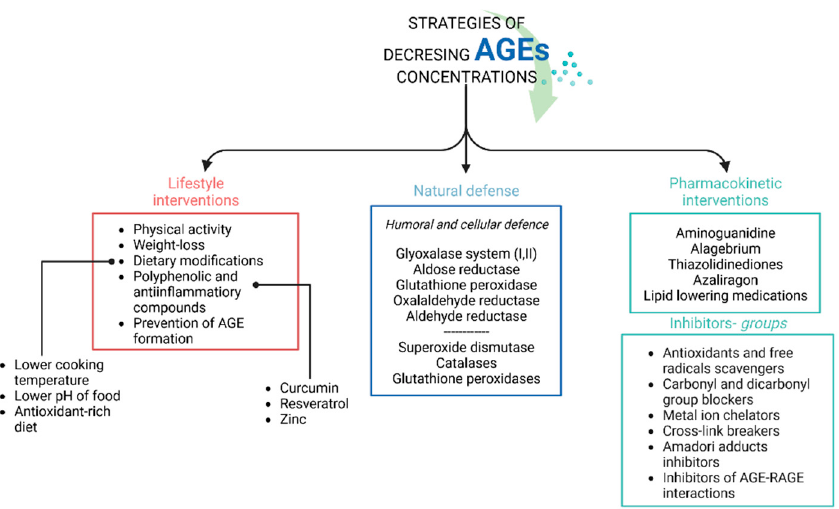
Figure 4. The main strategies aiming to reduce the accumulation of protein glycation end products in the body.